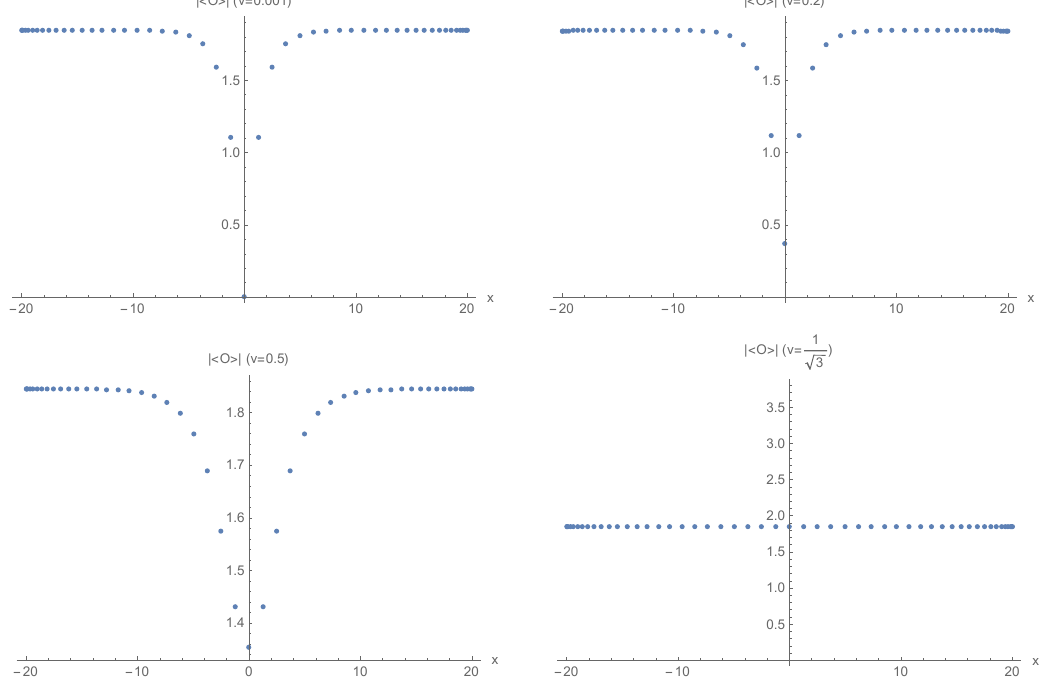
Figure 14 . The condensate distributions at various soliton speeds ( v = 0 : 001 ; 0 : 2 ; 0 : 5 ; 1 = the alternative quantization whith the chemical potential (cid:22) = 1 : 4. The values of jh O ij x =0 sequence 0.000959, 0.200329, 0.73415, 1 with the increasing velocities.